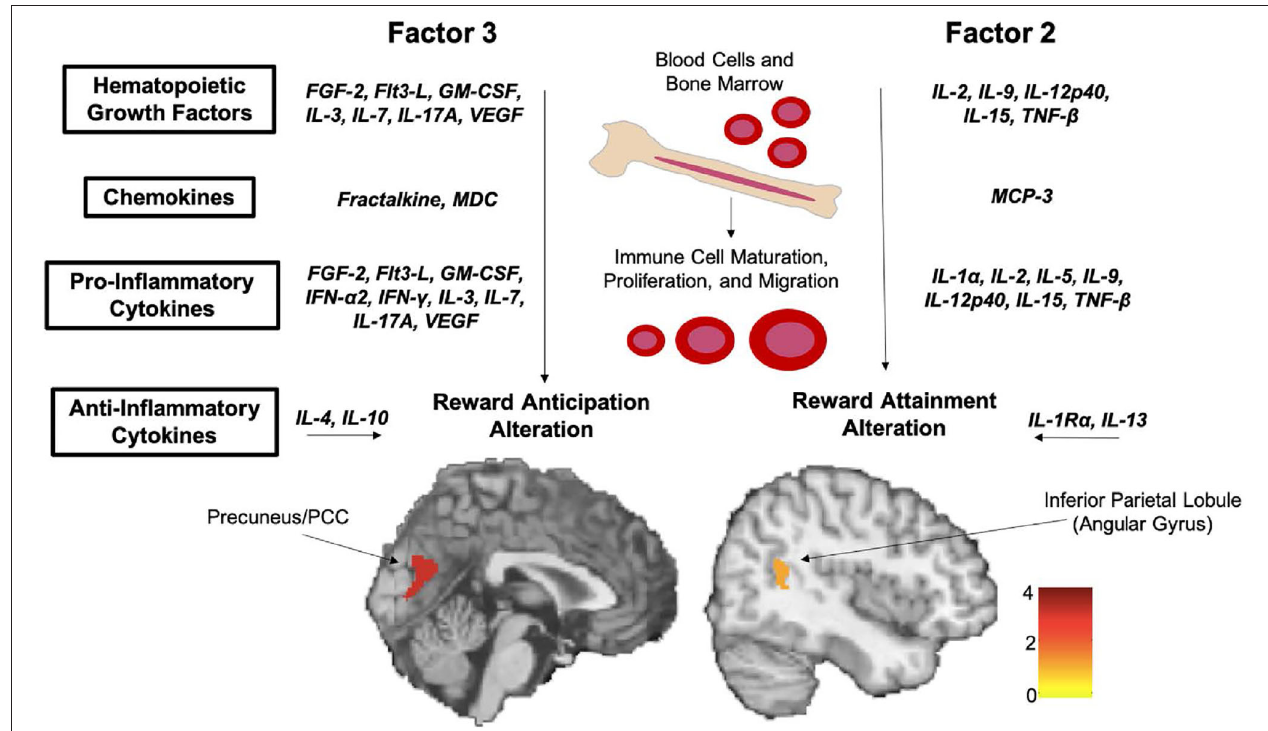
FIGURE 13 | Two factors identified by data-driven principal component analysis (PCA) of cytokine panels were found to significantly correlate with neural reward function in adolescents. Both factors were dominated by markers of inflammation and hematopoietic growth. Reprinted from (245). Scale bar indicates z -score.